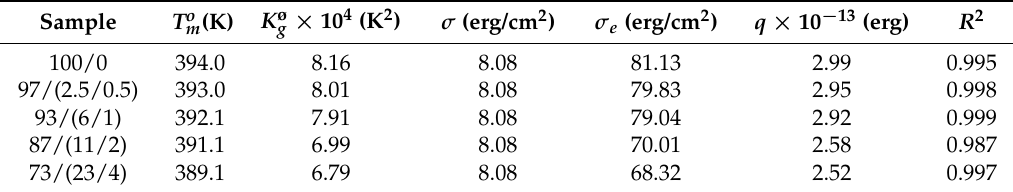
Table 3. Parameters from the isothermal crystallization kinetics analyses for neat PBS and the PBS/(PC/MWCNTs)